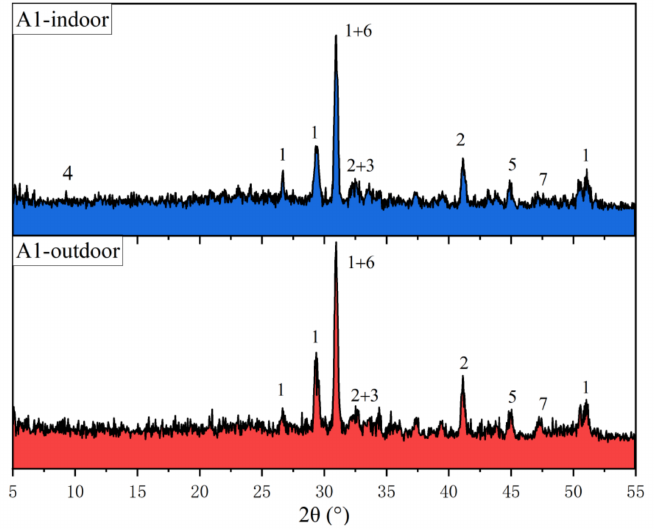
Figure 14. XRD patterns of UHPC based on composite cementitious material indoor and outdoor: 1- C - S - H , 2- C 2 S , 3- C 3 S , 4- AFt , 5- CS , 6- C - A - H , 7- CH , 8- CSH 2 .